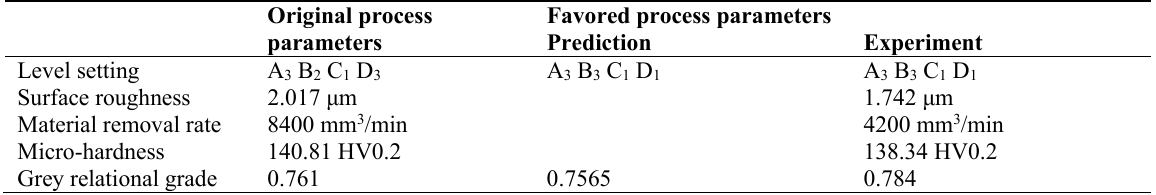
The outcomes of the confirmation experiment using the optimum machining parameters. Original process Favored process parameters parameters Prediction